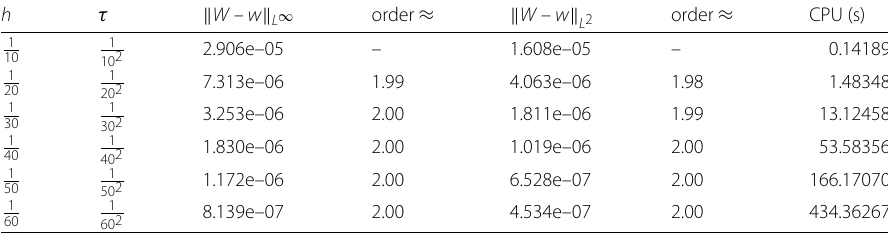
Table 6 Errors and computational orders of central difference scheme with β = 10 for